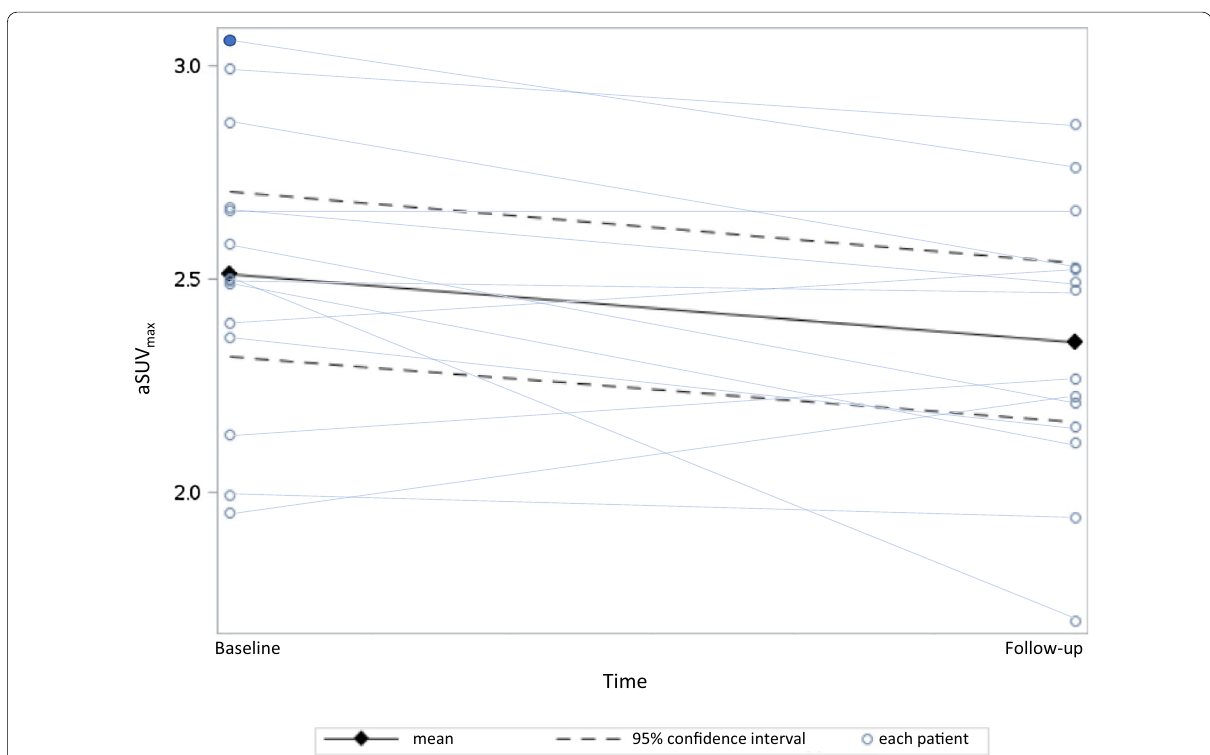
Fig. 3 Change in average maximum standardized uptake values (aSUV max ) from baseline to follow-up. The black diamonds represent the mean aSUV max at baseline and follow-up with the 95% confidence interval as the dotted line. Mean difference in aSUV max of P 0.034. The light blue lines represent each patient with the circles marking the aSUV max at baseline and follow-up. The patient with recurrent = symptoms undergoing carotid endarterectomy before the follow-up scan is marked as a filled